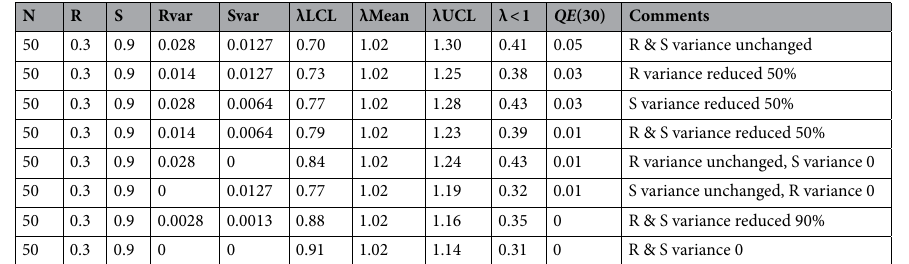
Table 4. Effects of biological variance (var; the component of variance due to temporal and environmental variation) in recruitment (R) and adult female survival (S) on the variability in λ. Results from 10,000 simulations with starting abundance (N) of 50, (year 10 of the 30 year simulation presented, with the values of extinction and quasi-extinction in year 10 essentially 0 (except QE (30), the quasi-extinction value at year 30)). Mean stochastic lambda (λ) with 90% CIs (LCL, UCL) and probability of scenarios resulting in stochastic λ < 1 (deterministic λ = 1.03). Biological variation was derived from the empirical recruitment and survival